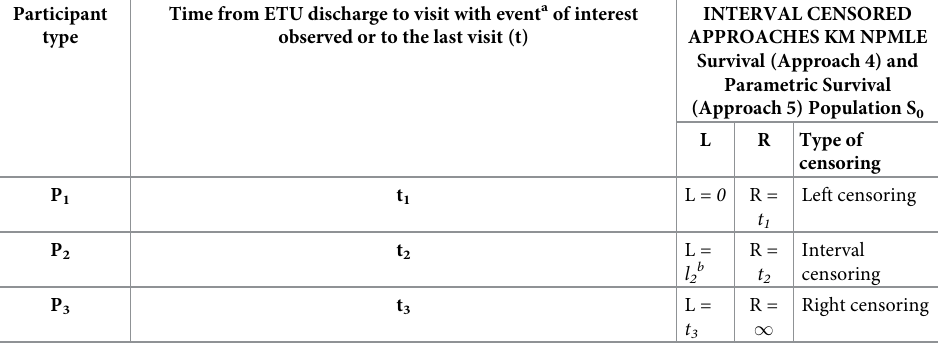
Table 2. Interval censoring methods: Distribution of the lower and the upper limits of censoring interval at which the failure time of interest, T occurred, for the three scenarios, based on population S 0 . Participant Time from ETU discharge to visit with event a of interest type observed or to the last visit (t)